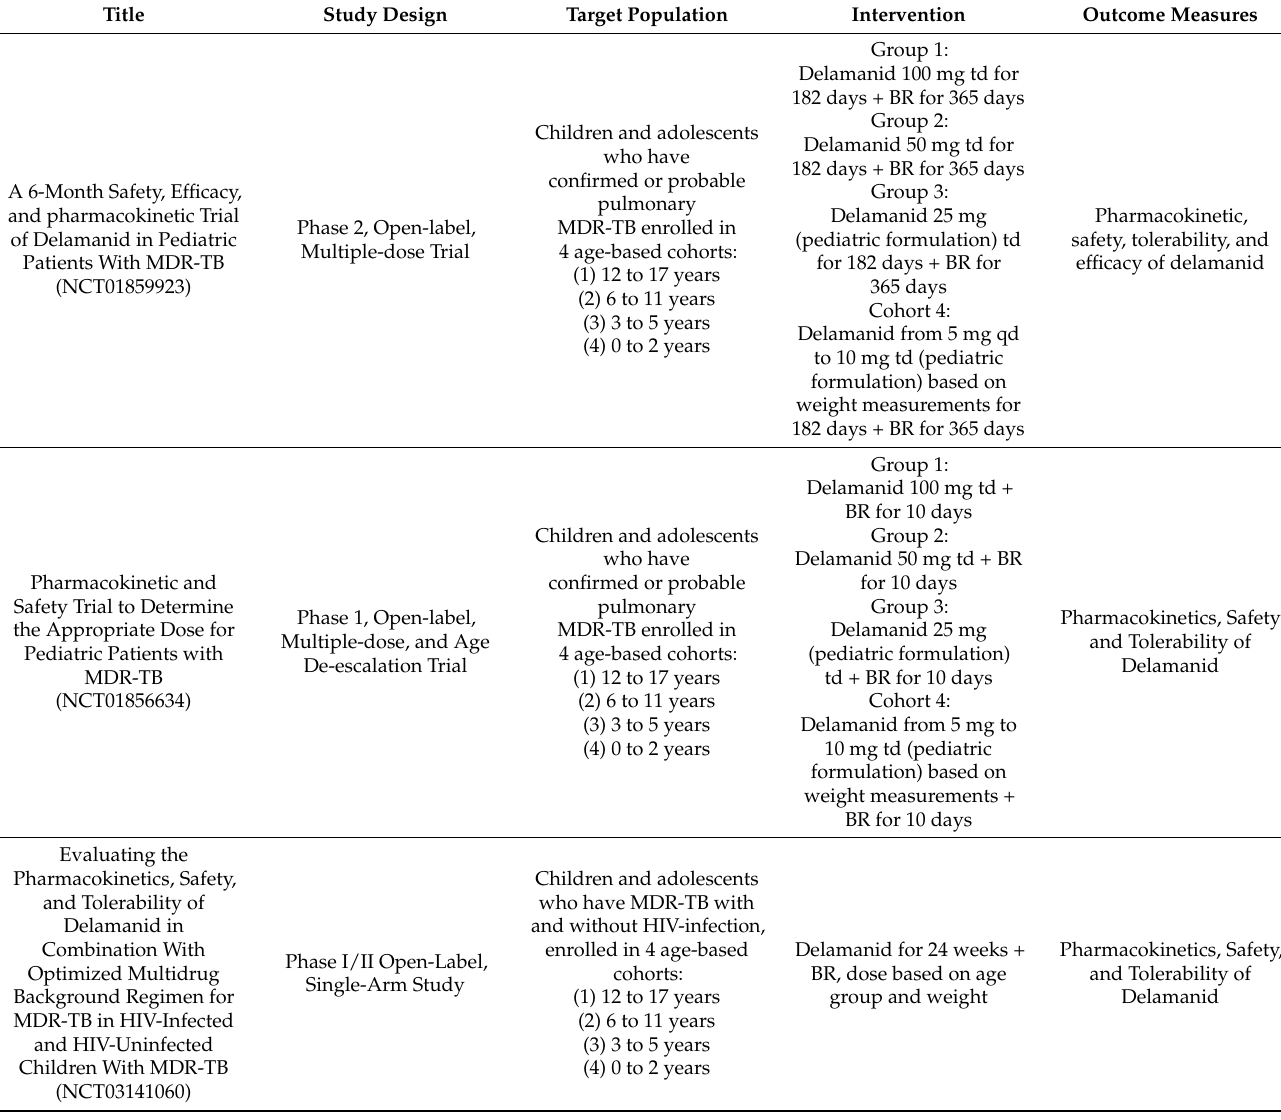
Study Design Target Population Intervention Outcome Measures